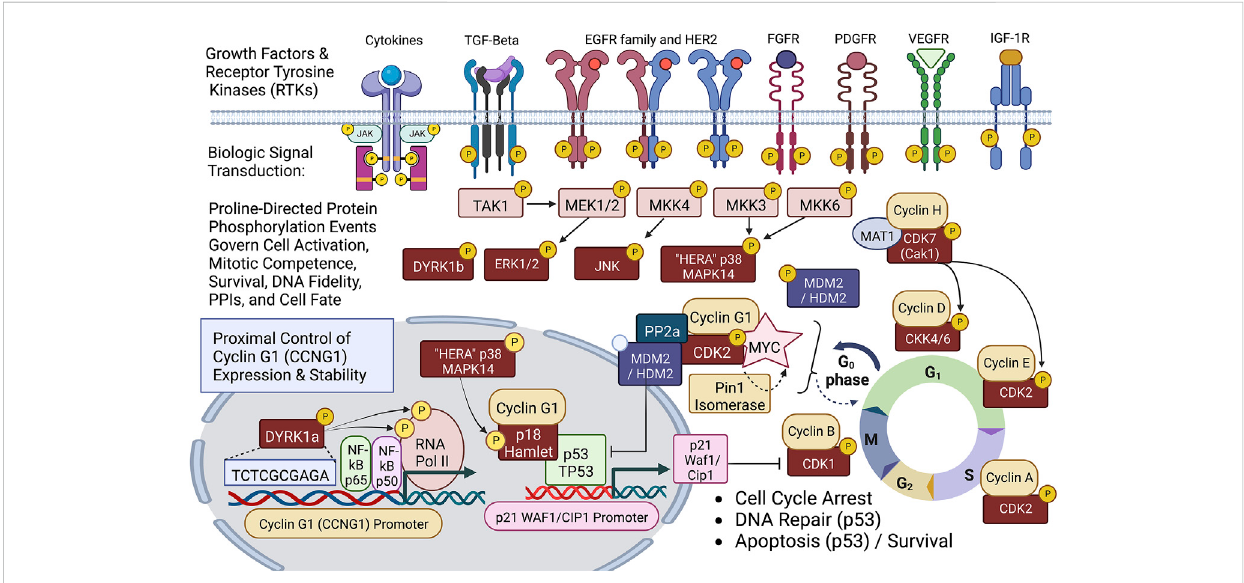
FIGURE 2 Diagram of site-speci fi c proline-directed protein phosphorylation events governing stem cell activation: Identifying the proximal bio-cybernetics, driving oncogenes, and executive enzymology at the foundations of stem cell activation, cellular transformation, stem cell survival, sustained proliferation, and cell cycle control. The diagram highlights the executive regulatory fl ow of site-speci fi c protein phosphorylation events linking the activation of major growth factor receptors to a series of mitogenic proline-directed signal transductions cascading through the “ Herakinase ” (p38, human EGF-receptor- associated Mapk14) and DYRK1a, directing immediate early events leading to the activation of the Cyclin G1 (CCNG1) promoter andexpressionofthePivotalCyclinG1/Cdk2/Myc/Pin1/Mdm2/HDM2/p53Axisofcellcyclecontrol.Note:CyclinG1interactsphysicallywithp18Hamlet, a transcriptional activator and target substrate of p38 Hera/Mapk14, which mediates p53-dependent transcriptional responses to DNA damage and genotoxic stress in proliferative cells. Moreover, p38 Mapk14 and p18 Hamlet are implicated in chromatin-remodeling and transcriptional activation complexes associated with muscle differentiation. See text for additional